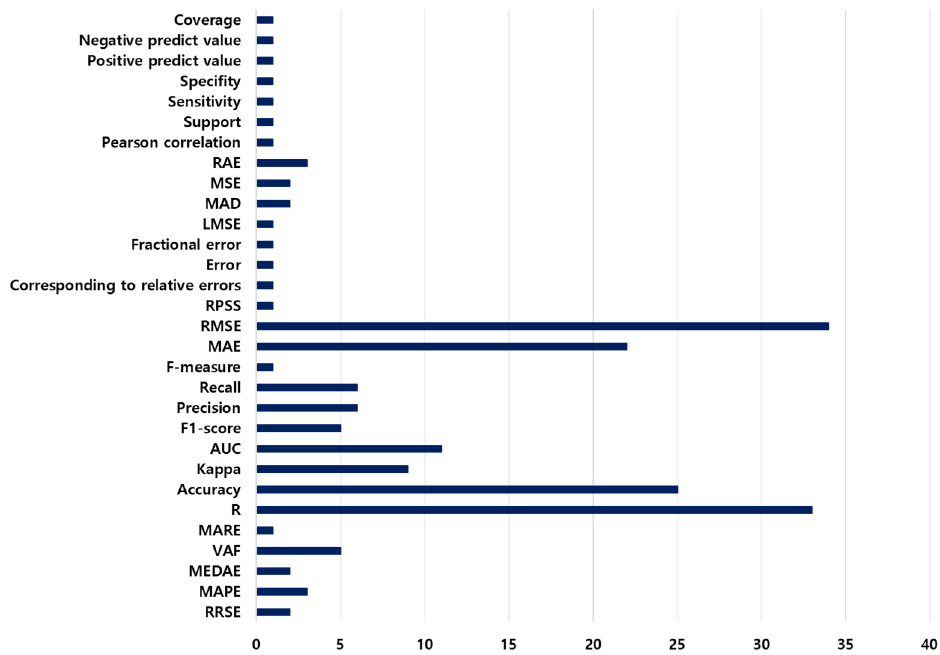
Figure 12. Studies employing different performance measurements(RAE: relative absolute error; MSE: mean squared error, MAD: mean absolute difference, LMSE: least mean square, RPSS: rank probability skill score, RMSE: root mean square error, MAE: mean absolute error, AUC: area under the curve, R: coefficient of determination, MARE: multivariate adaptive regression spline, VAF: variant allelic frequencies, MEDAE: median absolute error, MAPE: mean absolute percentage error, RRSE: root relative squared error).